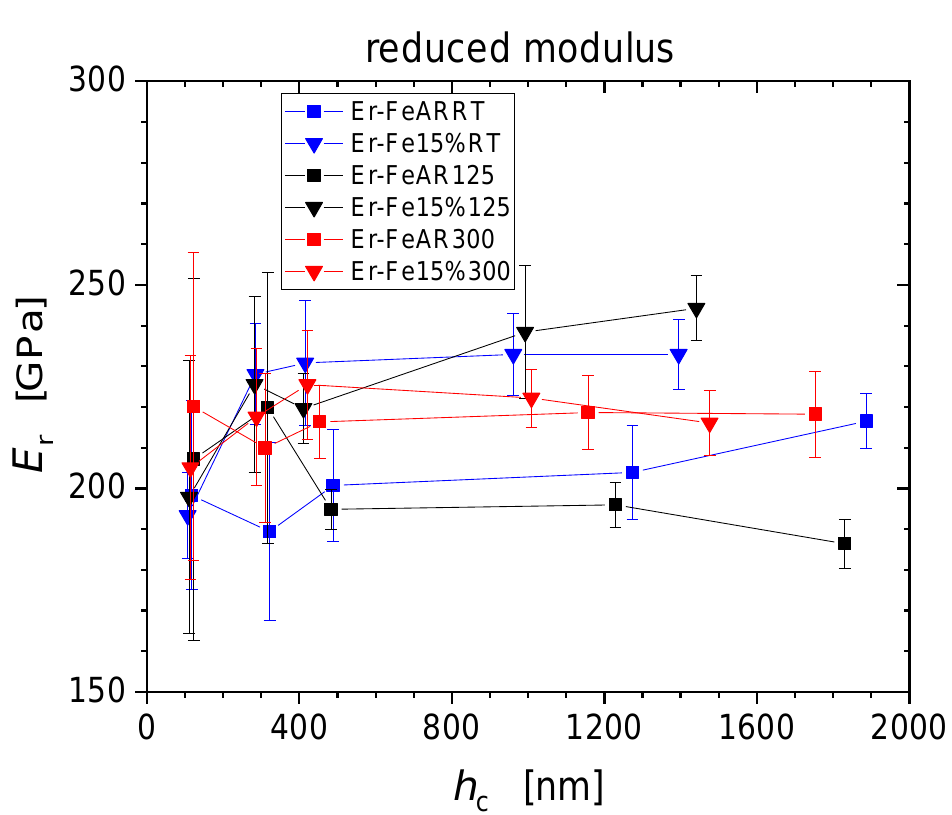
Figure 8. Reduced modulus values obtained from nanoindentation measurements and used for EMC procedure.